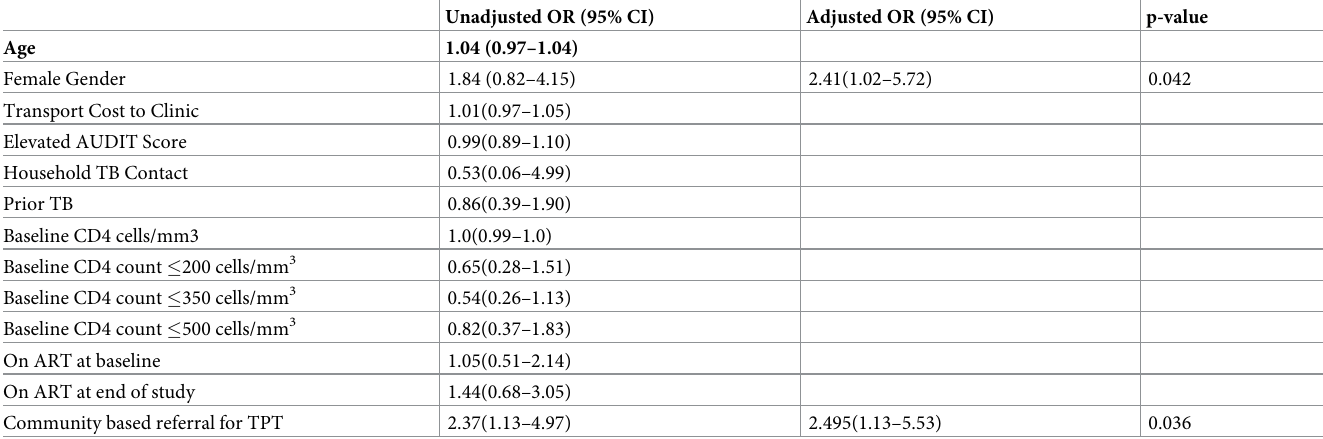
Table 3. Predictors of TPT